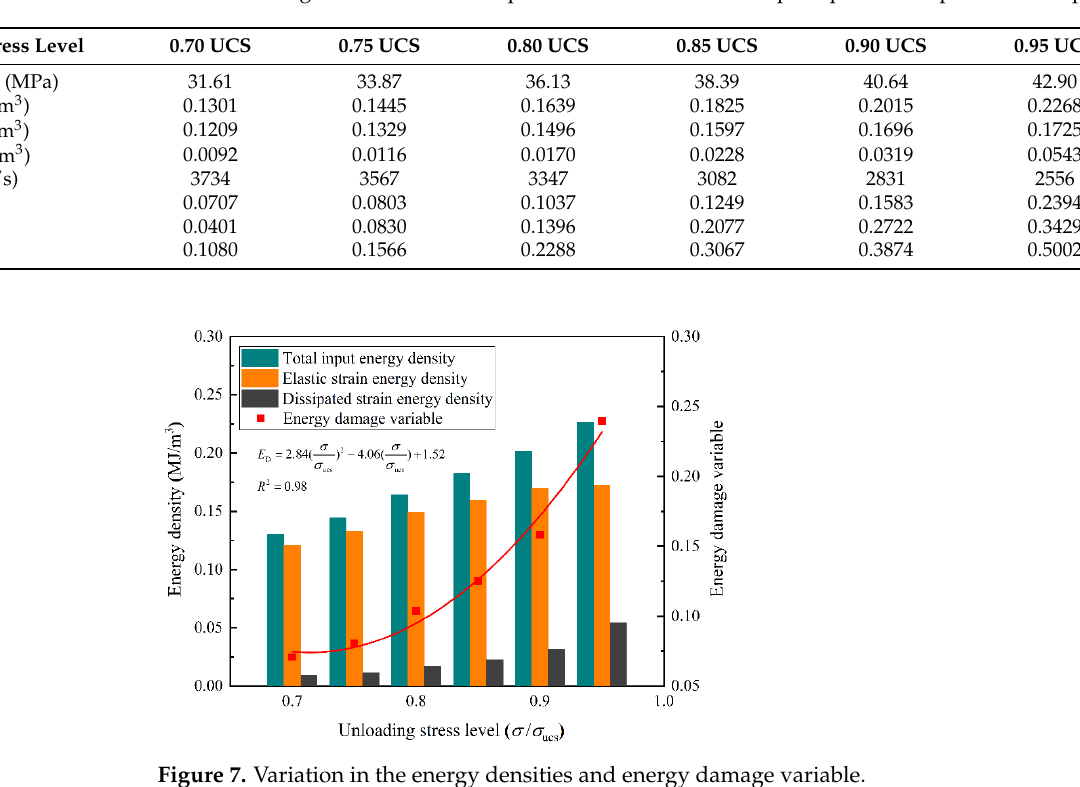
Figure 8. Variation in the P-wave velocity and damage variables. 3. Dynamic Test Results 3.1. Effect of Accumulated Damage on Stress-Strain Curves Dynamic uniaxial compression tests were performed on sandstone specimens with different accumulated damage conditions, and dynamic stress-strain curves at different strain rates were obtained (Figure 9). Overall, for each accumulated damage condition, an increase in strain rate has a dramatically enhanced effect on dynamic uniaxial compres- sive strength (DUCS). This rate effect has been verified in dynamic impact tests for most rocks [54 – 57]. As the